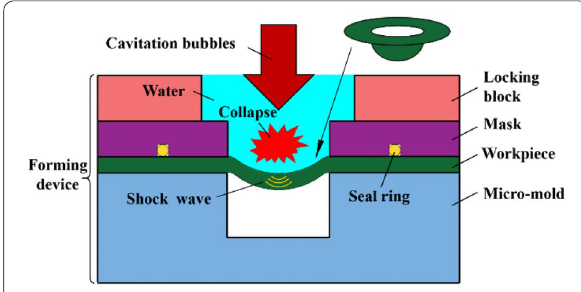
Figure 8 Schematic of water-jet cavitation shock